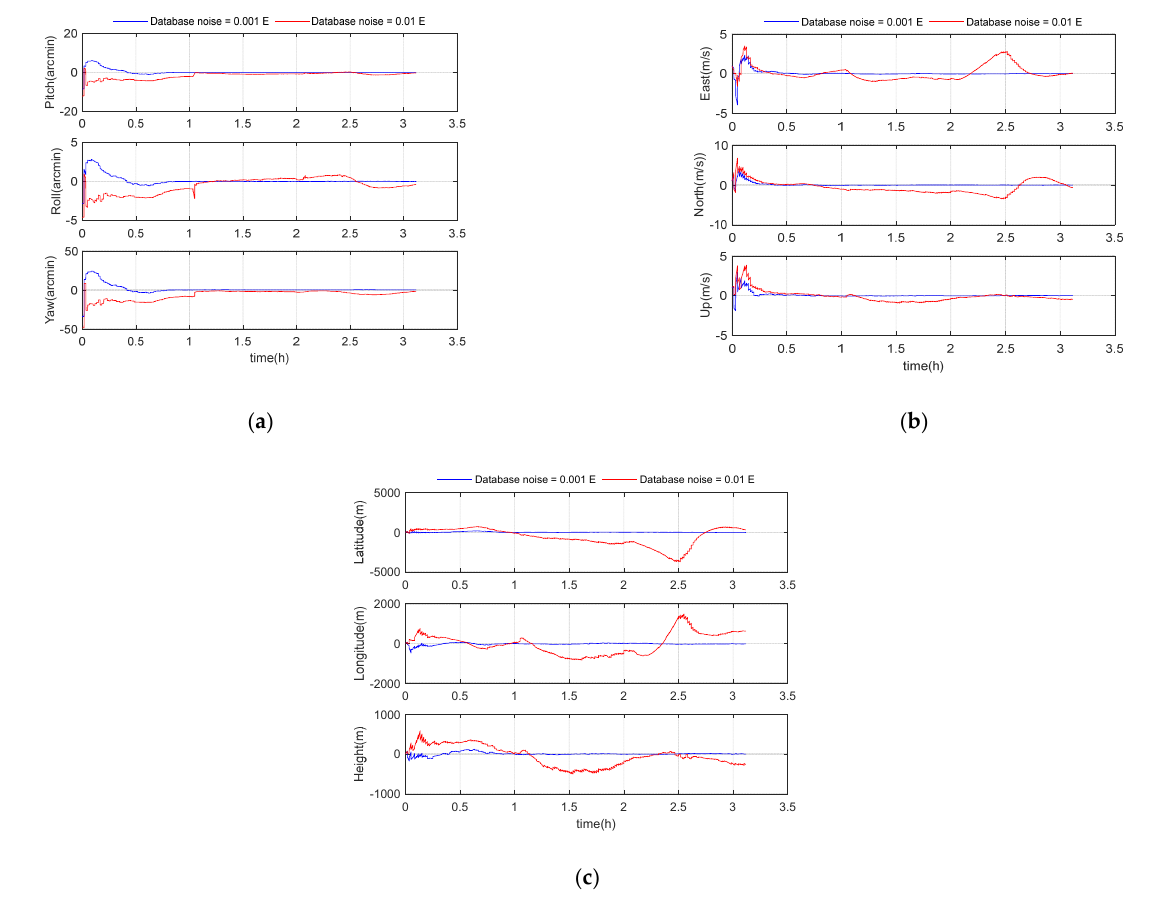
Figure 6. ( a ) Attitude error curve; ( b ) velocity error curve; ( c ) position error curve. Table 5. Simulation results under different database noise.